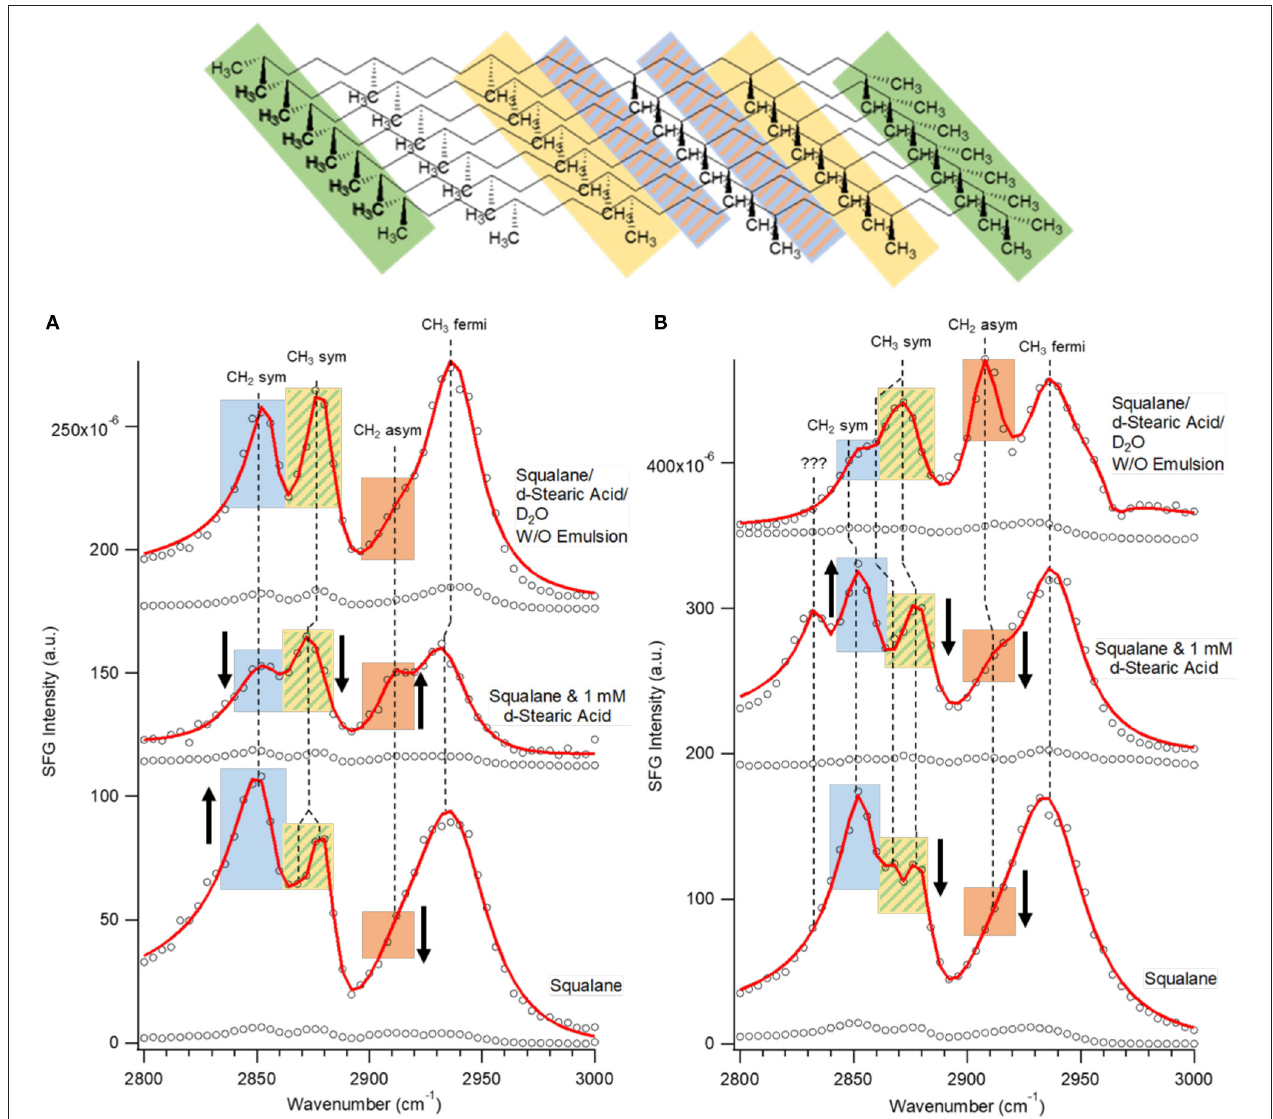
FIGURE 3 | SFG spectra of biomimetic emulsion and control fluids at PEO (A) and PS (B) surfaces in the C-H vibrational region and SSP polarization combination. Spectra and fits are represented by black circles and red dots, respectively. Five vibrational modes were observed in all of the spectra: near 2,855, 2,868, 2,880, 2,914, and 2,935 cm − 1 corresponding to CH 2 symmetric, CH 3 symmetric, CH 2 asymmetric, and CH 3 Fermi vibrations, respectively. Colored bars indicate vibrational mode locations on a layer of squalane molecules present at the interface. Black arrows indicate relative change in mode amplitude from the same mode in the spectrum above